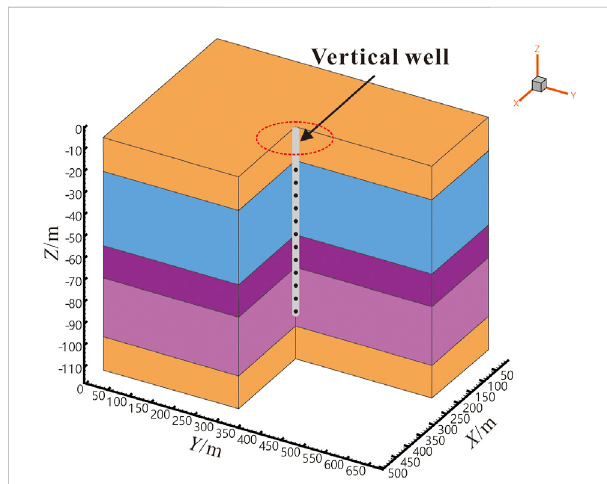
FIGURE 3 Schematic diagram of vertical well position in the model.